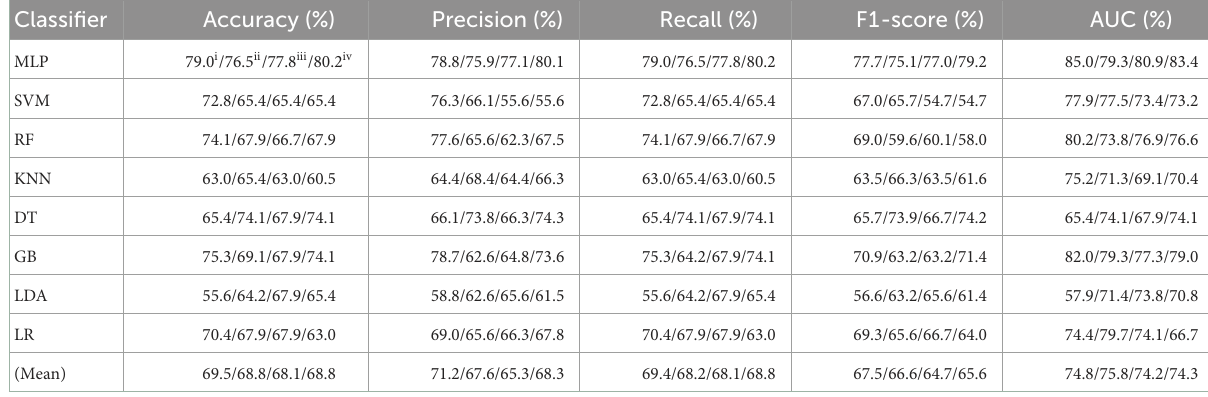
TABLE 2 Evaluation metrics of the different classifiers with four original combination features (Experiment 1) on the test set.